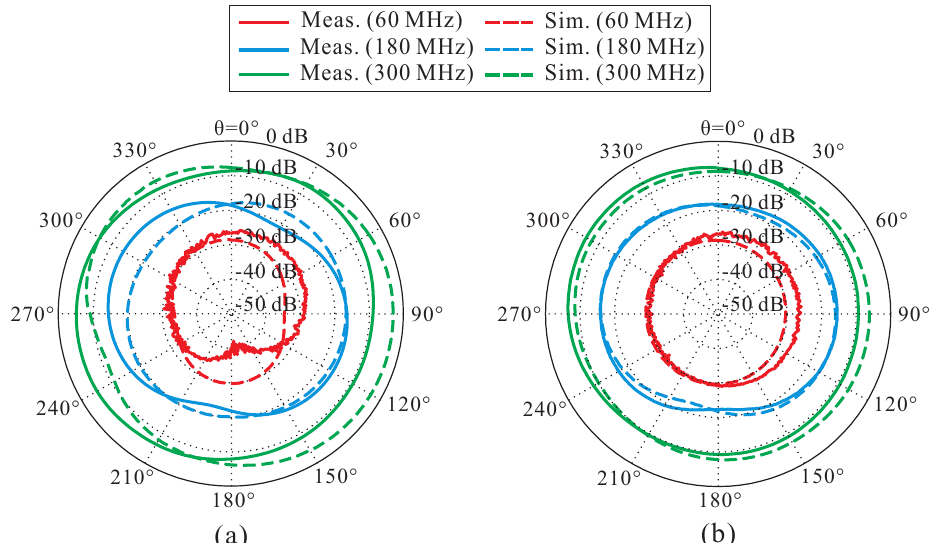
Figure 8. Simulated and measured radiation patterns of the proposed antenna at 60, 180, 300 MHz: ( a ) xz -plane; ( b ) yz -plane.